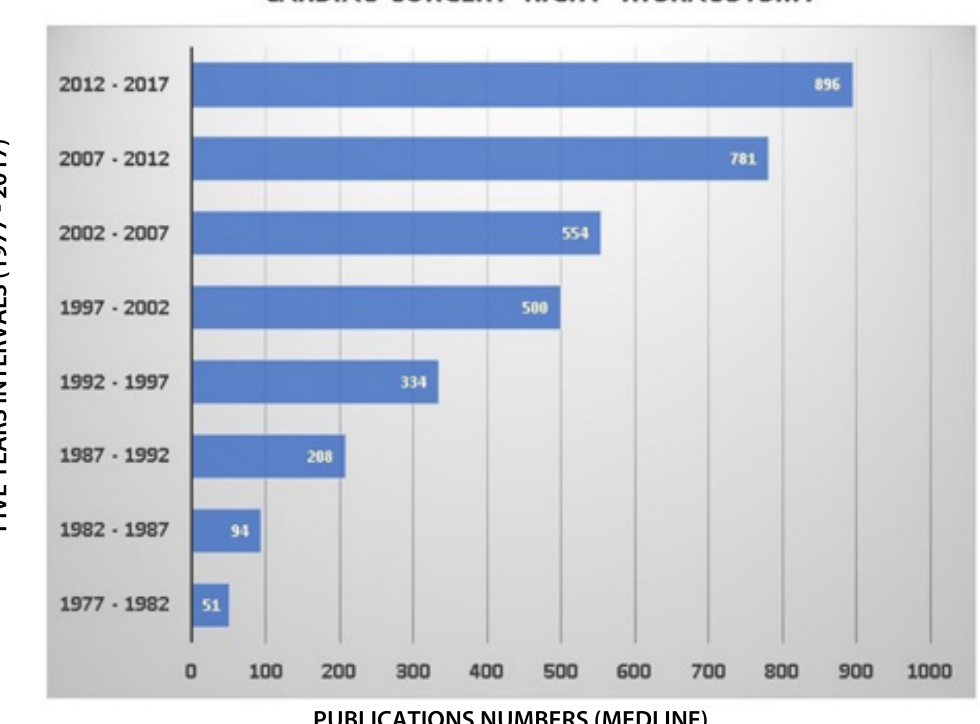
Fig. 1 - Five-year distribution of publications over thirty years (1977-2017), based on a free MEDLINE database search (“Right thoracotomy and cardiac